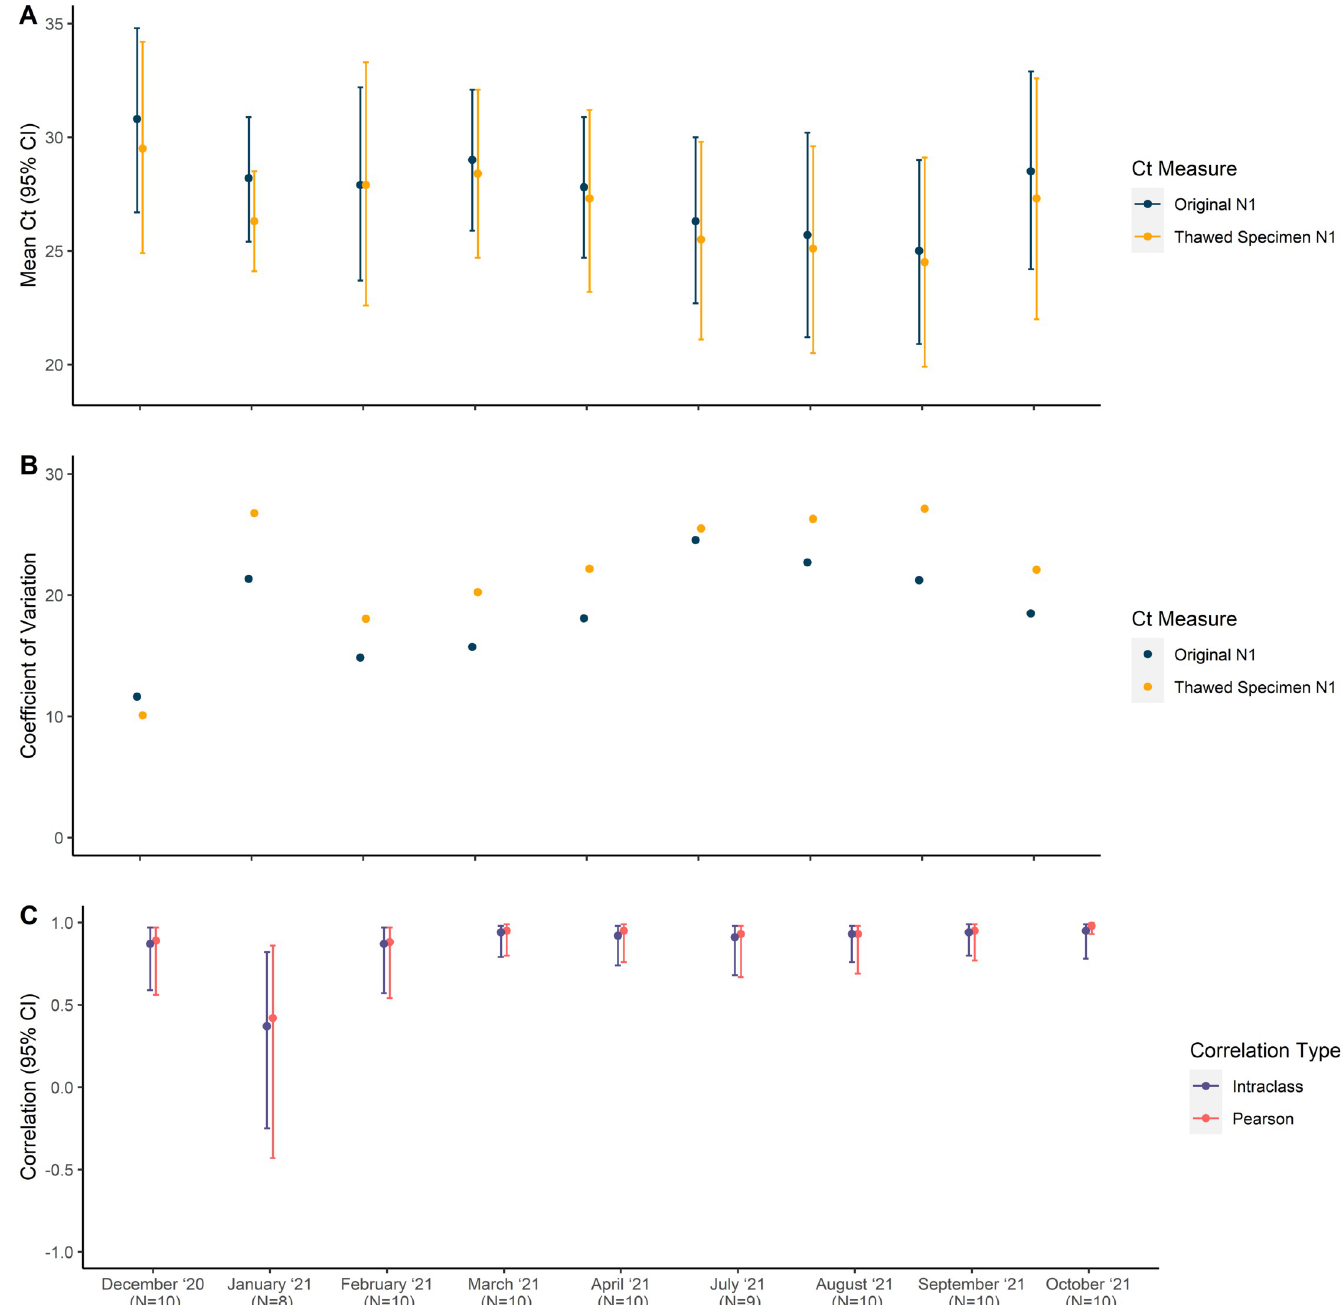
Fig 2. Test and re-test Ct values vary over time but remain highly correlated, except for January. A) The mean Ct values were highest in December 2020 and then decreased over the next 8 months before rising again in September 2021. B) The coefficient of variation across the study period stayed consistently below 30 and were similar within each month. C) The test and re-test Ct values are strongly correlated (Pearson correlation > 0.70) and demonstrate good reliability (Intraclass correlation > 0.75) across the entire study period except for January, indicating that frozen saliva swabs can remain reliable over long periods of